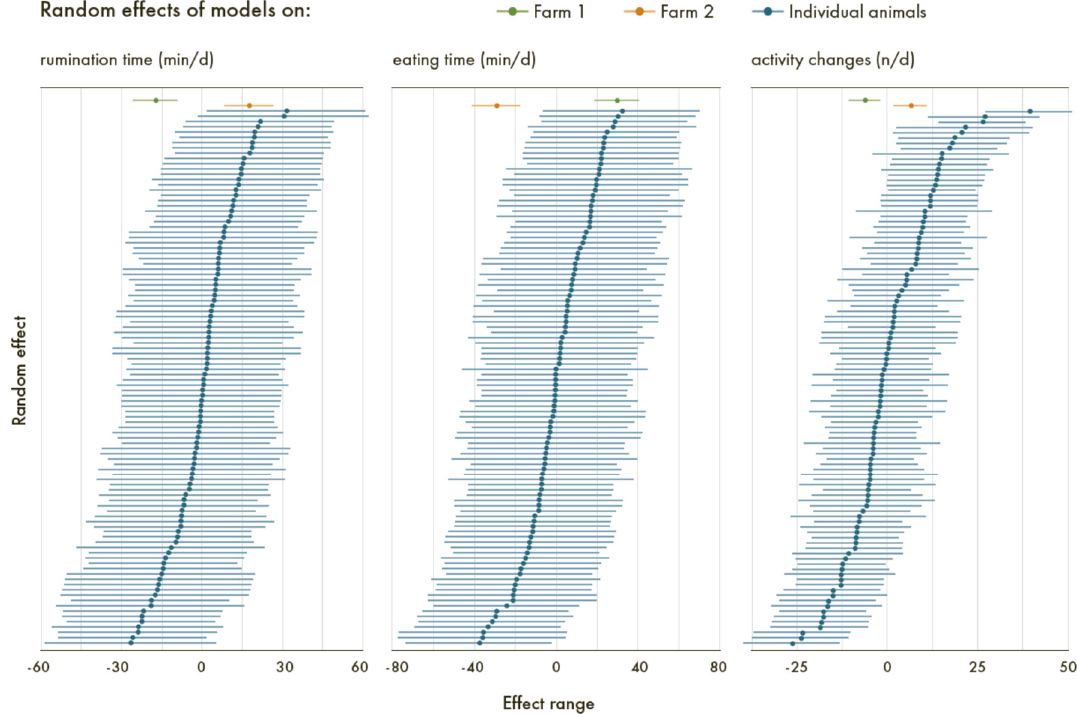
Figure 3. Plots of the random effects farm and animal from models on chewing sensor variables. The plots show the mean effect (dot) and the confidence interval (horizontal lines) of farm or animal on the respective mean model estimate, represented by the 0 value.